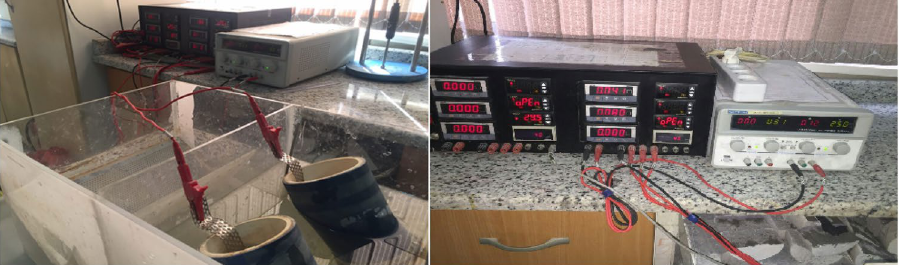
Fig. 5 The test setup of RCMT applied in this